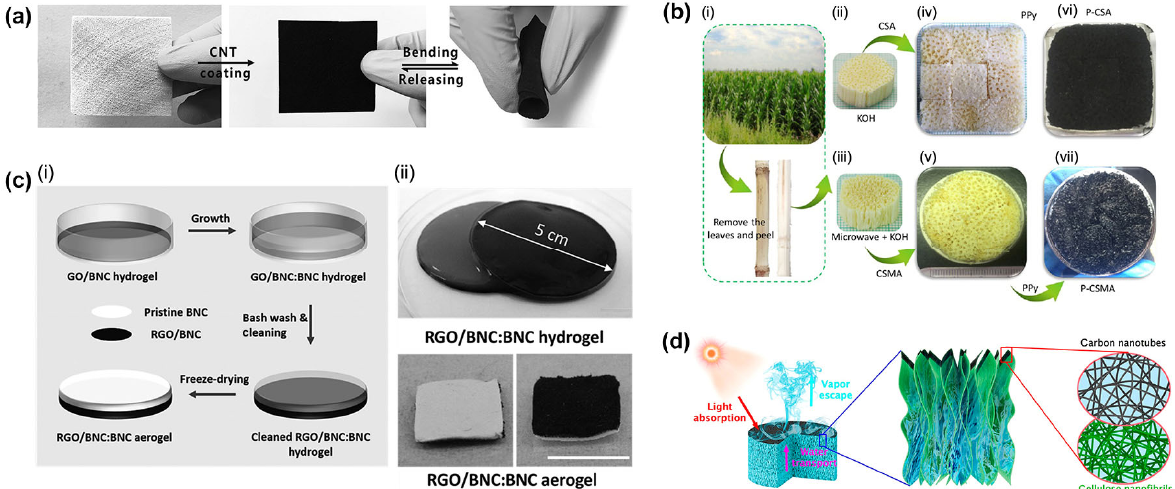
Figure 5 Biomass-based and foamed structure substrates. (a) The flexible wood membrane substrate. Reproduced with permission from Ref. [68], © WILEY-VCH Verlag GmbH & Co. KGaA, Weinheim 2017. (b) The corn straw-based substrate. Reproduced with permission from Ref. [73], © American Chemical Society 2019. (c) A bilayer hybrid biomass foam substrate. Reproduced with permission from Ref. [76], © WILEY-VCH Verlag GmbH & Co. KGaA, Weinheim 2016. (d) A bilayer-structured aerogel is composed of two types of nanofibers. Reproduced with permission from Ref. [77], © American Chemical Society